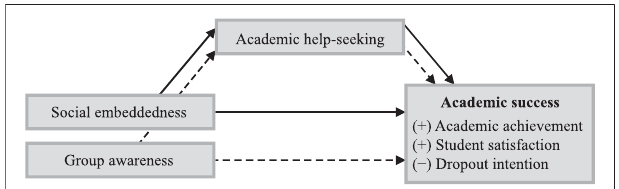
FIGURE 1 | Social variables (Social Embeddedness and Group Awareness) are expected predictors for academic success measures. Whereas academic help-seeking is expected to be a